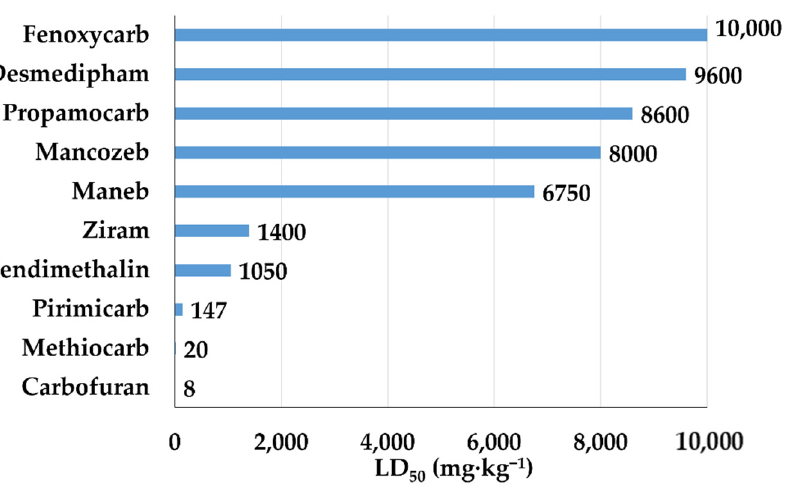
Figure 7. LD 50 (mg · kg − 1 ) of carbamates for rat. The carbamates act as acetylcholinesterase inhibitors and endocrine disruptors. Exposure to carbamates causes respiratory diseases.